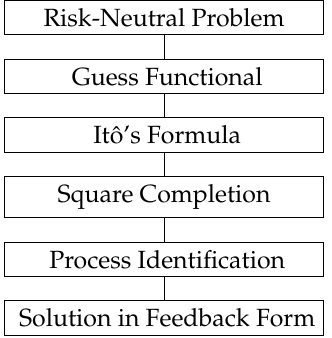
Figure 1. Methods developed in this work. Cooperative vs. noncooperative. Adversarial/robust vs. nonzero-sum mean-field-type